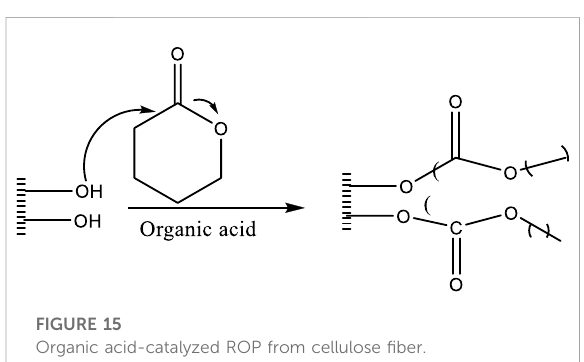
FIGURE 15 Organic acid-catalyzed ROP from cellulose fi ber.